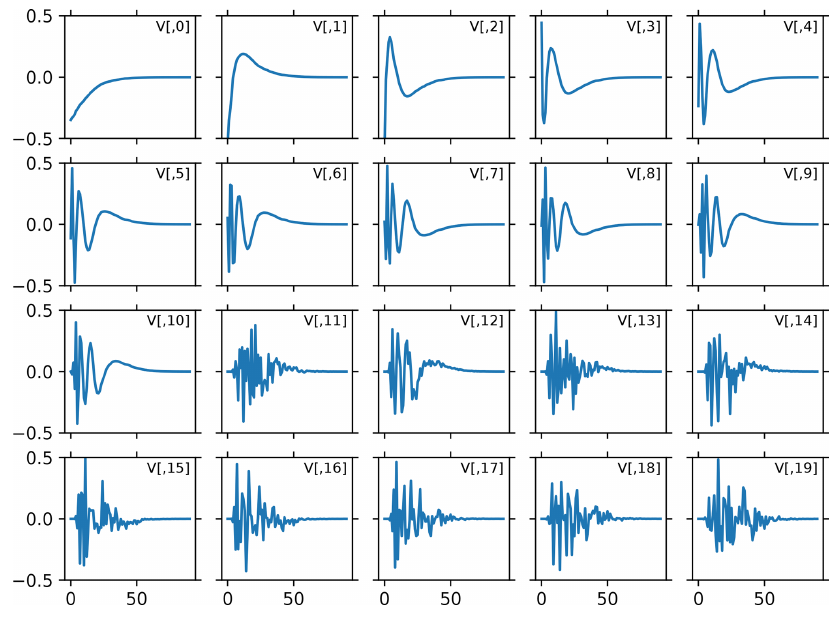
Figure 6. The first 20 basis functions from the V matrix.